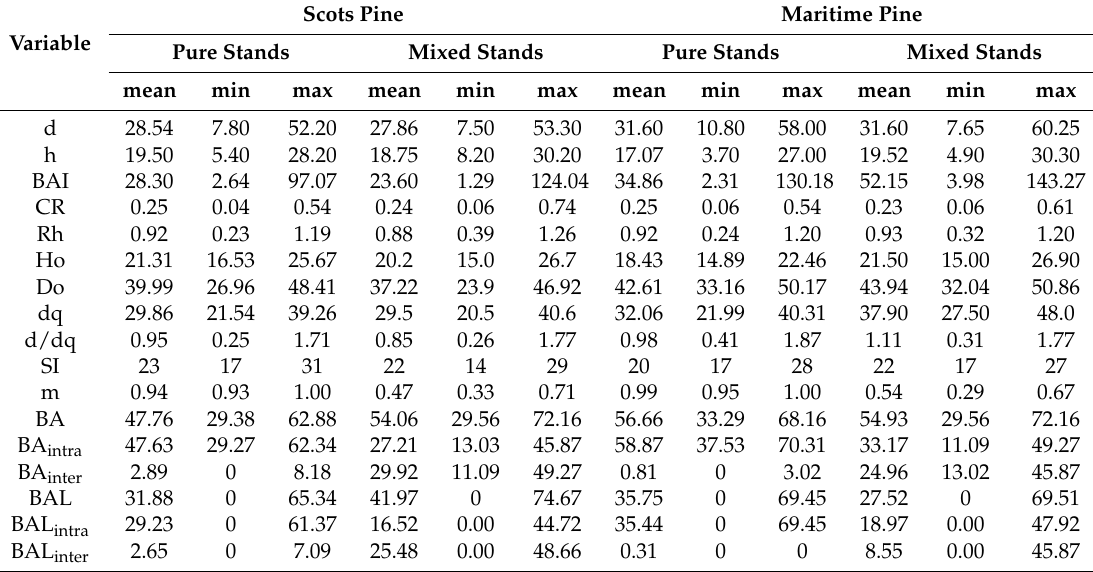
Table 1. Tree and plot-level attributes in mixed and pure plots for each species across triplets. Scots Pine Maritime Variable